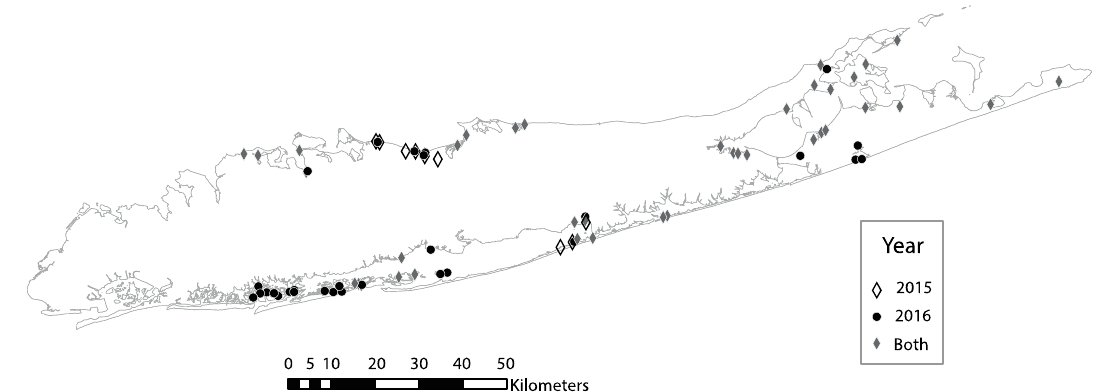
Figure 1. Location of diamondback terrapin and snail surveys in 2015, 2016, and in both 2015 and 2016 in Long Island, NY.